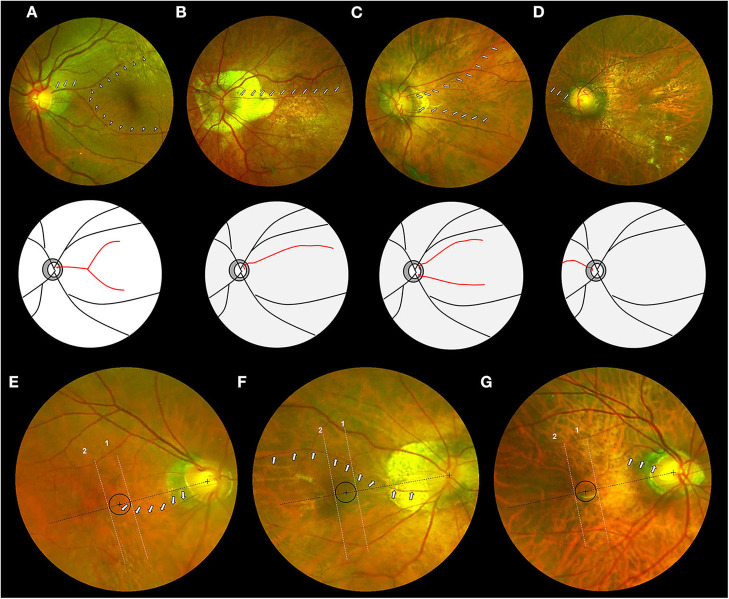
Photographic classification system for cilioretinal arteries in highly myopic eyes. (Top row) Fundus photographs of four categories of cilioretinal arteries. (A) Category 1: eyes with a temporal “cake-fork” cilioretinal artery (white arrows) with two main branches (white arrowheads). (B) Category 2: eyes with a temporal “ribbon” cilioretinal artery (white arrows). (C) Category 3: eyes with multiple cilioretinal arteries (white arrows). (D) Category 4: eyes with a nasal cilioretinal artery (white arrows). (Middle row) Schematic diagrams of four categories of cilioretinal arteries (red lines) corresponding to the top row. (Bottom row) Fundus photographs of three distributions of cilioretinal arteries. Black circle represents the area within 500 μm of the foveal center. Lines 1 and 2, both vertical to the dashed black line that connects the centers of the fovea and the optic disc, are used to differentiate the types of distribution. (E) Type A: eyes with a cilioretinal artery (white arrows) whose path (or visible branches) reaches the area within 500 μm of the foveal center. (F) Type B: eyes with a cilioretinal artery (white arrows) whose path (or visible branches) extends across the central region. (G) Type C: eyes with a cilioretinal artery (white arrows) whose path (or visible branches) does not reach the central region.